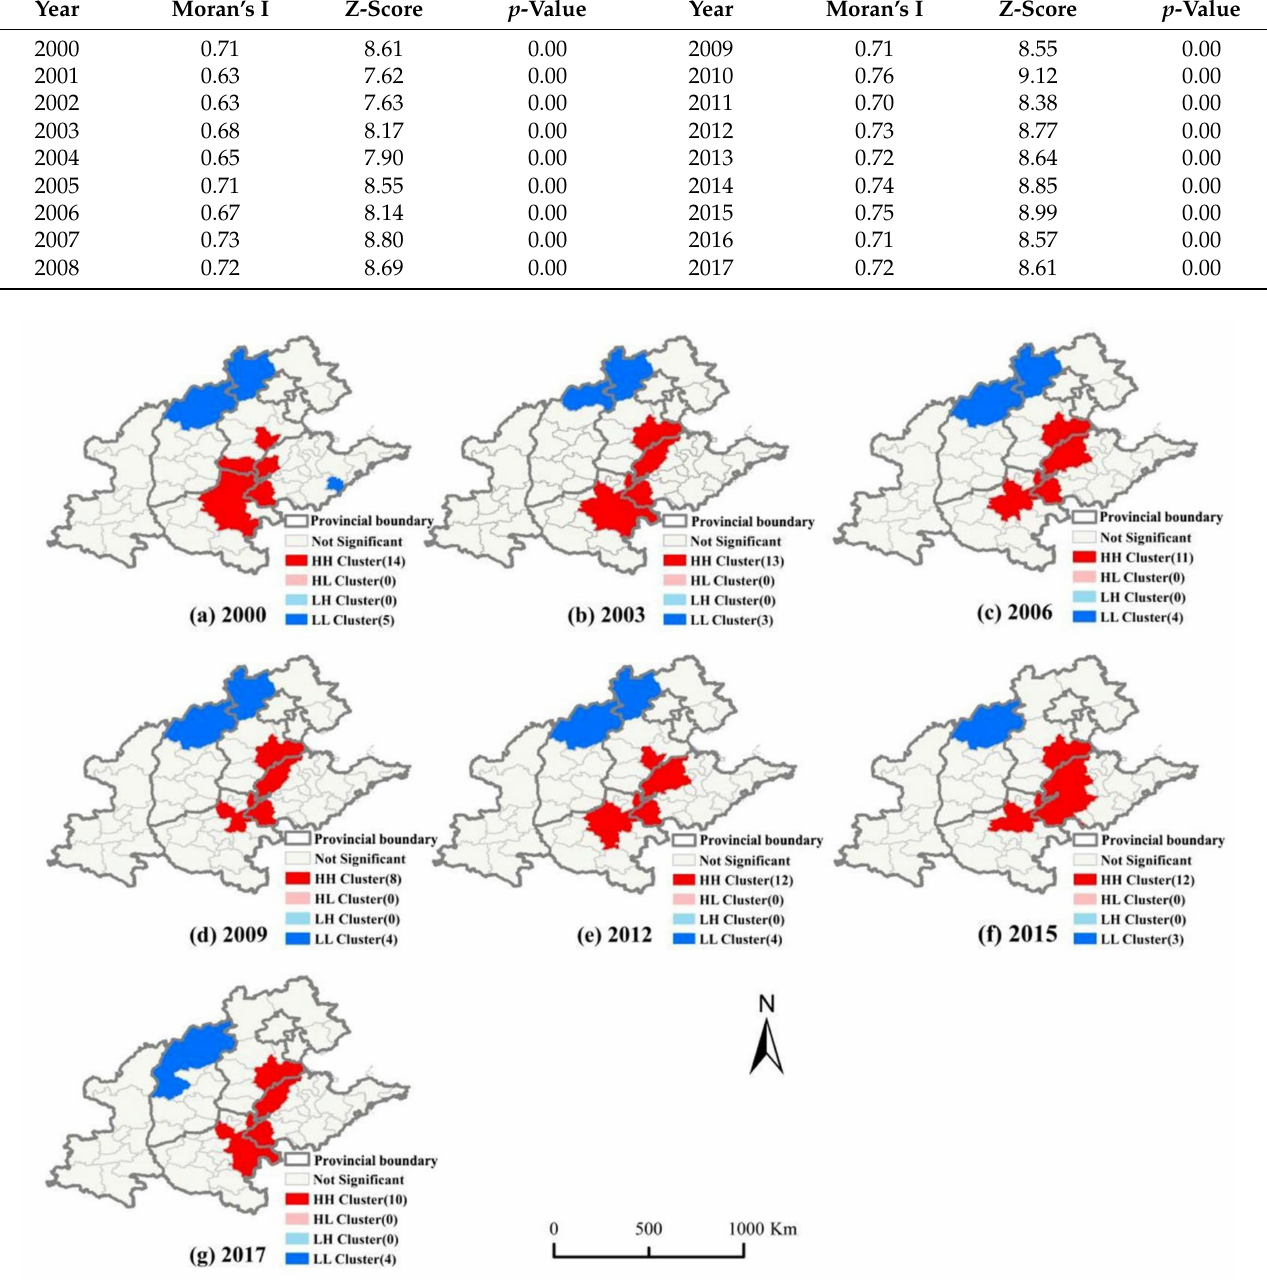
Table 2. Results of Global spatial autocorrelation Moran’s I index from 2000 to 2017.